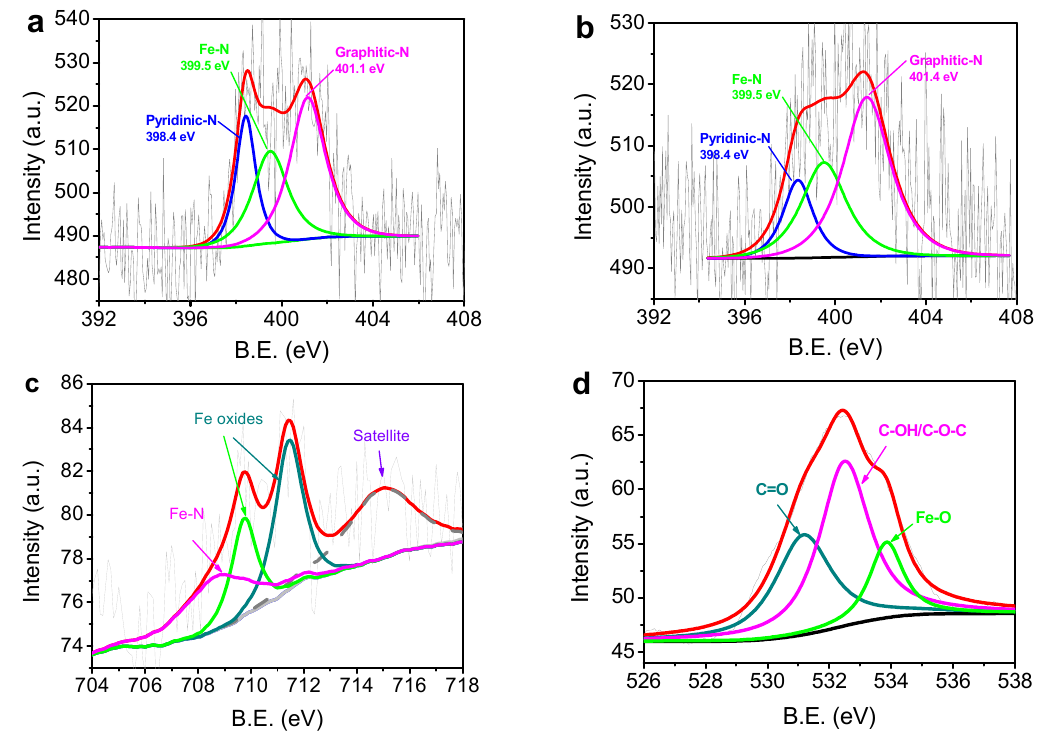
Figure 3. N 1s X-ray photoelectron spectroscopy (XPS) spectra of N-C@CNT ( a ) and N-C@CNT-Fe ( b ); Fe 2p 3/2 ( c ) and O 1s ( d ) XPS spectra of N-C@CNT-Fe. B.E.: binding